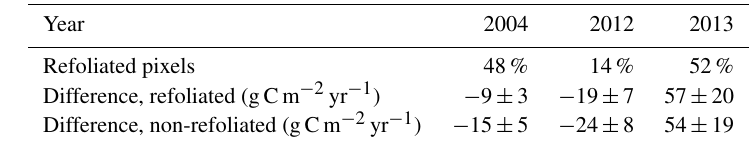
Table 3. Differences in GPP loss (gCm − 2 yr − 1 ) between methods 1 and 2 for MODIS pixels with recovering foliage later in the season, and pixels with no refoliation according to the defoliation monitoring method. Higher GPP loss with Method 2 gives negative values.